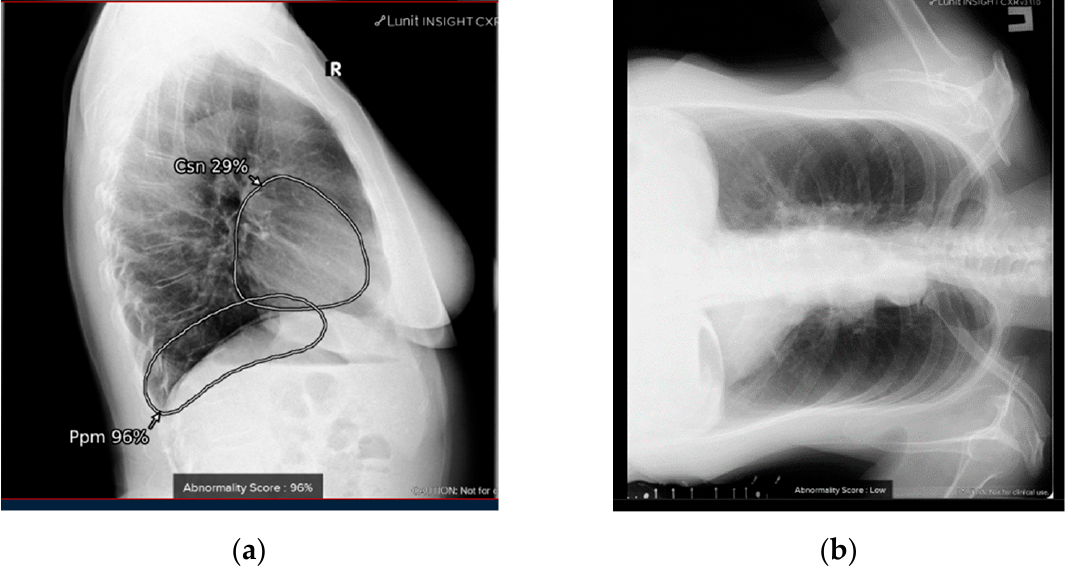
Figure 2. Examples of the technical defects: lateral instead of frontal projection was analyzed by the AI system ( a ); the image with relevant radiological findings is rotated, and the study was reported by a radiologist as having right lower lobe opacity ( b ).